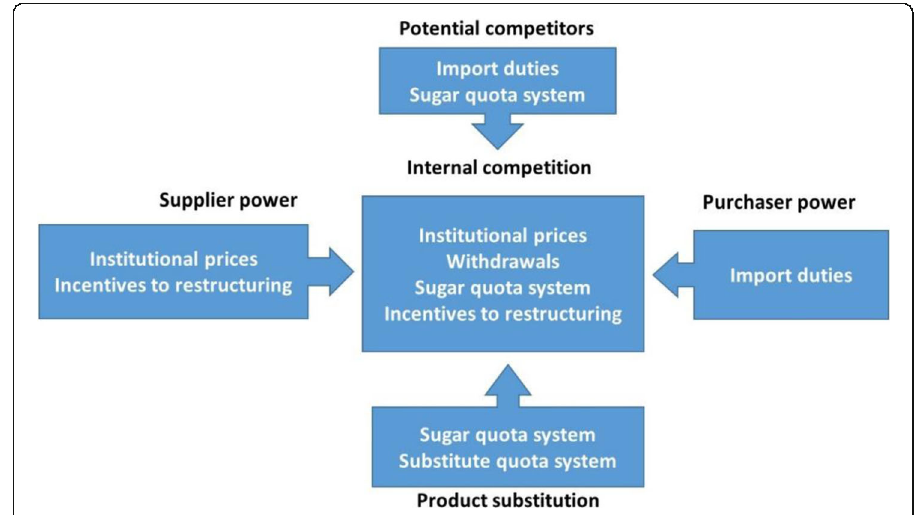
Fig. 2 Potential effect of sugar CMO Reform on competition. Source: Areté srl Research and Consulting in Economics,